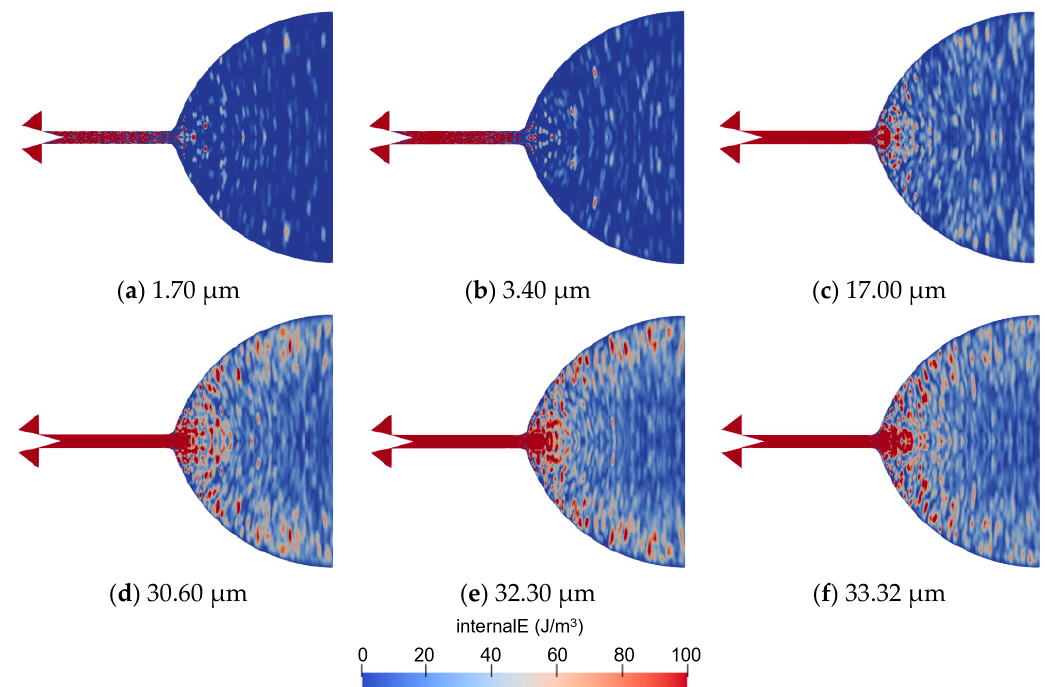
Figure 9. Molecular internal energy fields in the axial plane with different needle displacements at t = 0.1 ms . t = 0.1